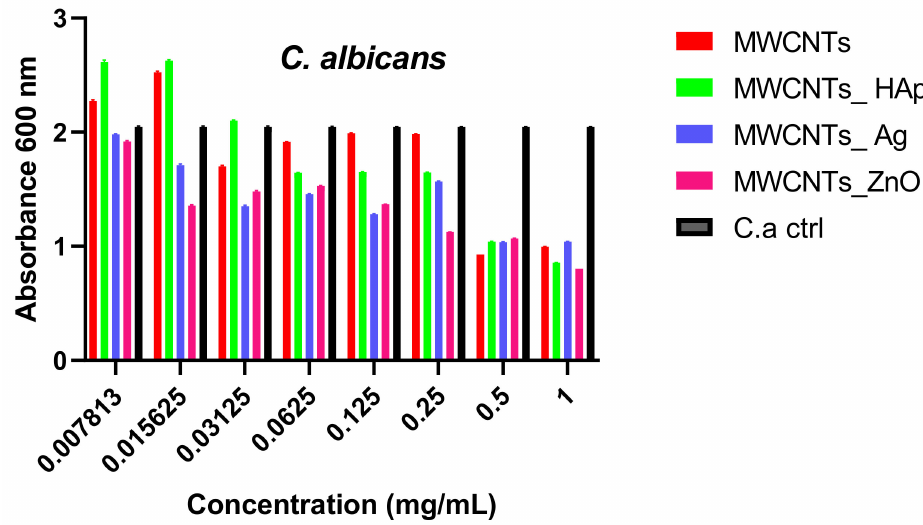
Figure 14. Graphical representation of the minimum concentration for eradication of biofilm for MWCNTs and decorated MWCNTs on the fungal pathogen C. albicans . Data represented were mean of triplicate values with standard deviation.